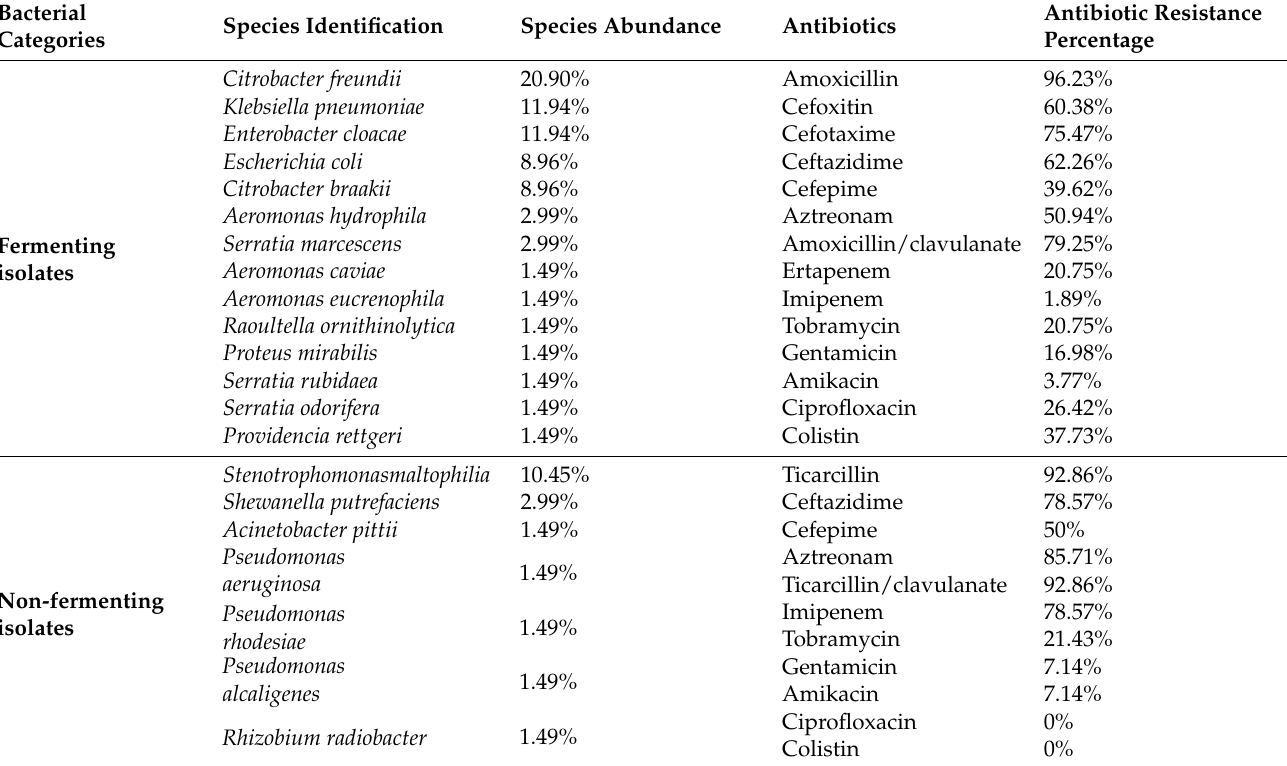
Table 1. Bacterial species abundance and antibiotic resistance